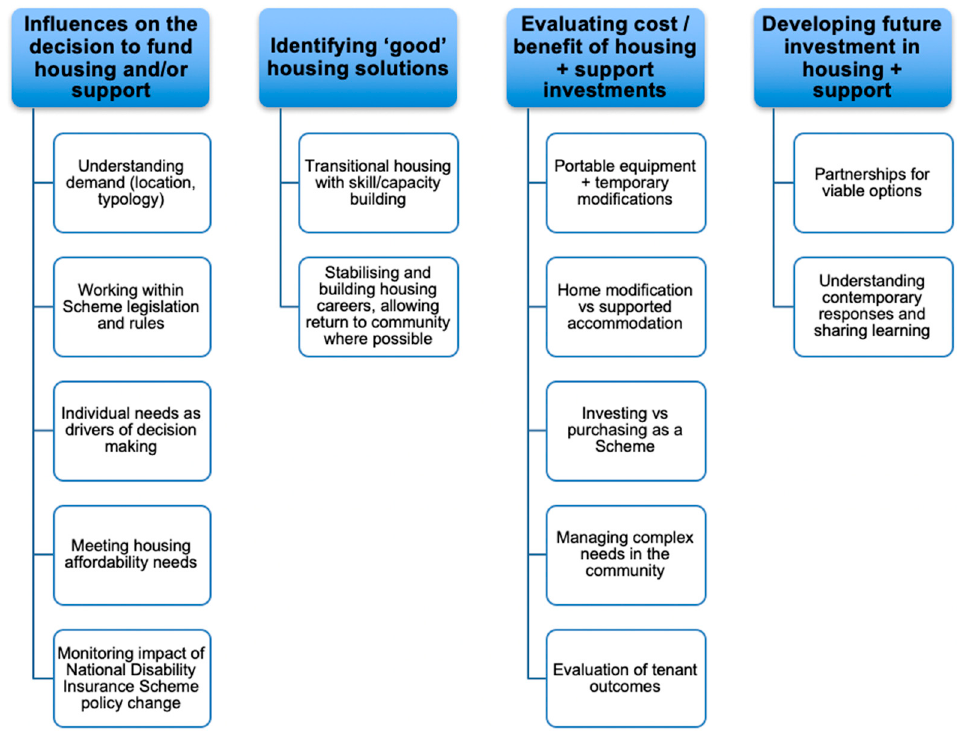
Figure 1. Themes